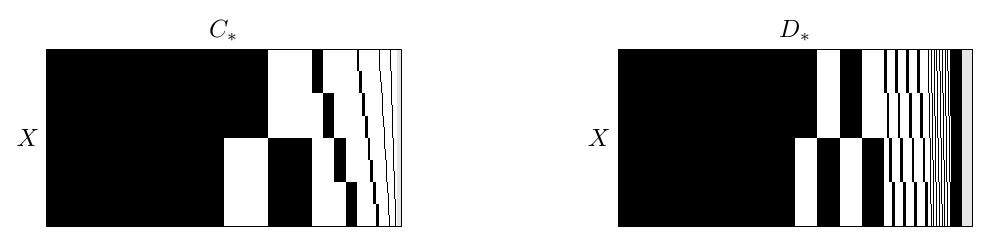
Figure 16: The composite tiles X × C ∗ (in the left) and X × D ∗ (in the right) for X ∈ A ∗ ∪ B G